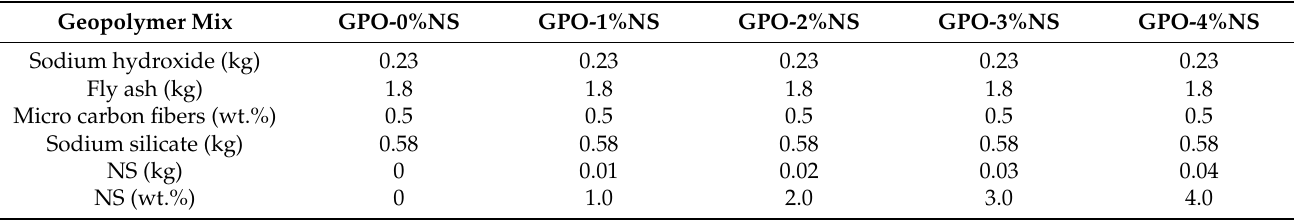
Table 4. Composition of all five mixes.